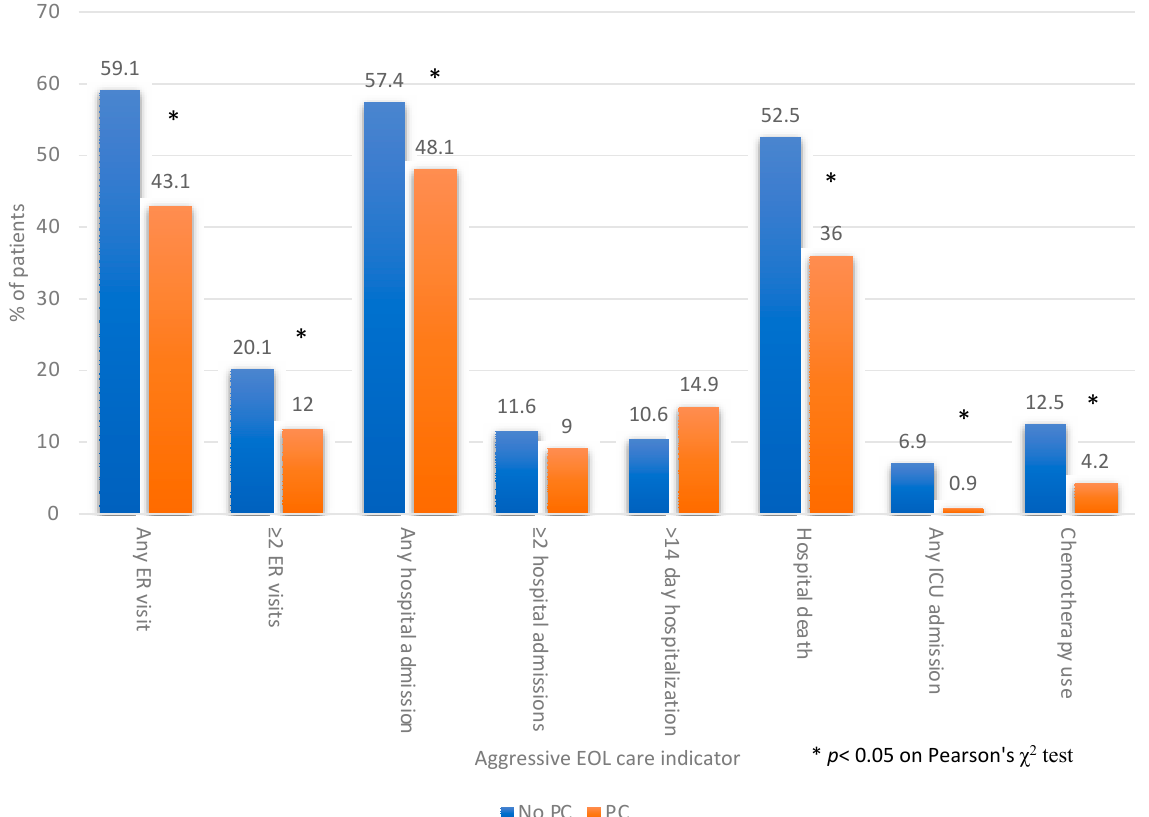
Figure 2. Proportions of indicators of aggressive care at the end of life (EOL) in last 30 days of life, based on occurrence of palliative care (PC) consultation ( N = 1414).